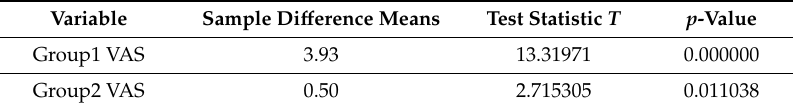
Table 10. t -Student tests for means of dependent samples.